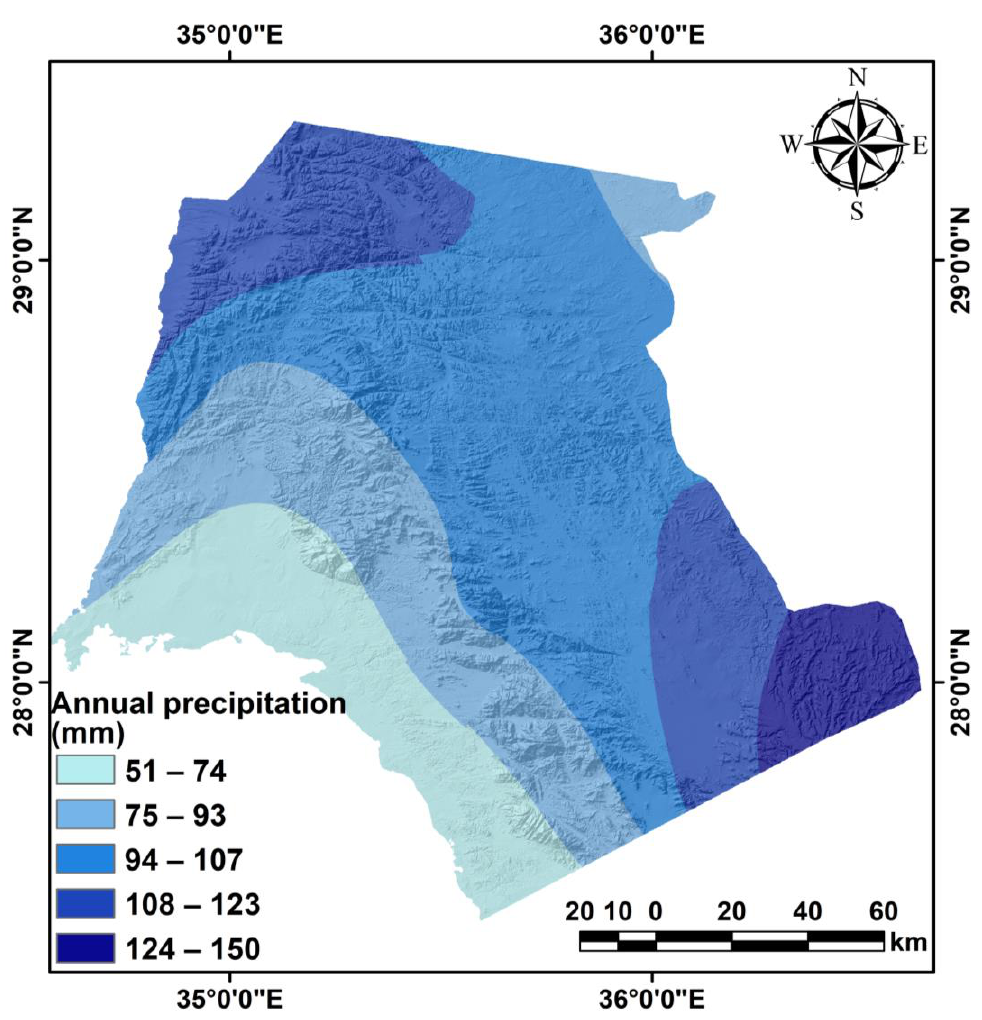
Figure 8. Map presenting the annual precipitation average for the study region. The northwest and southwest regions of Neom receive the most precipitation.